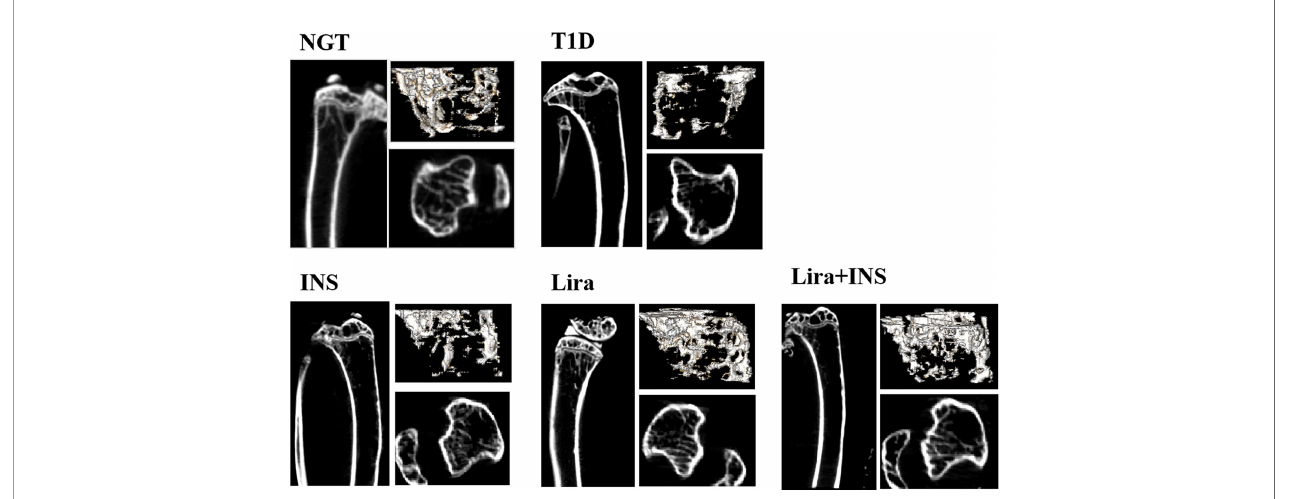
FIGURE 2 | Typical 2D and 3D images of micro-CT. NGT, normal glucose tolerance group; T1D, type 1 diabetes group; INS, insulin treatment group; Lira, liraglutide treatment group; INS+Lira, insulin + liraglutide treatment